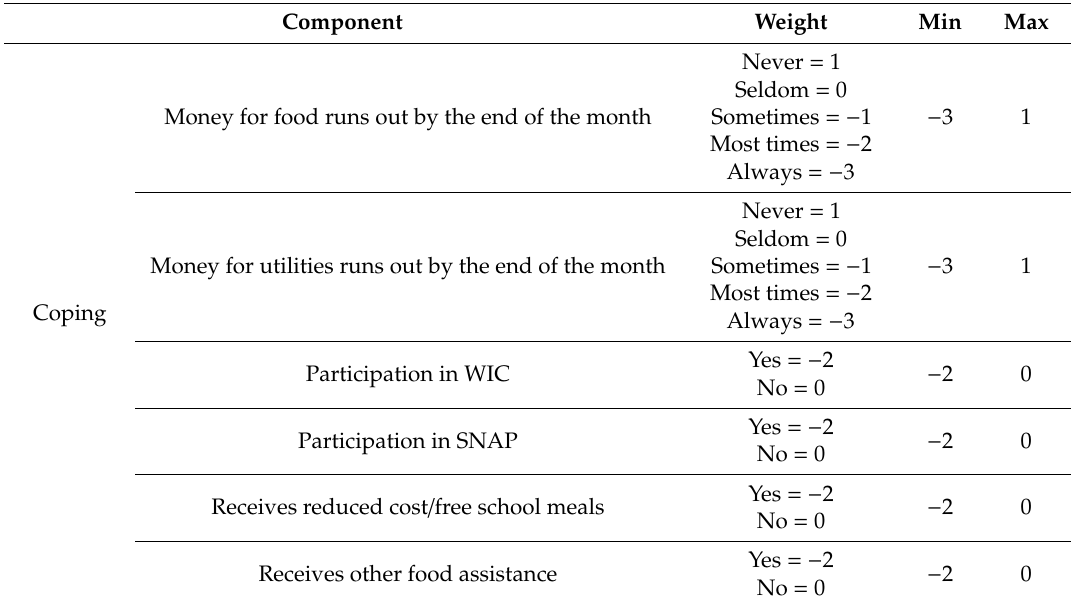
Table 1. The adapted infant food security index a components, weights, scores, and ranges applied to this